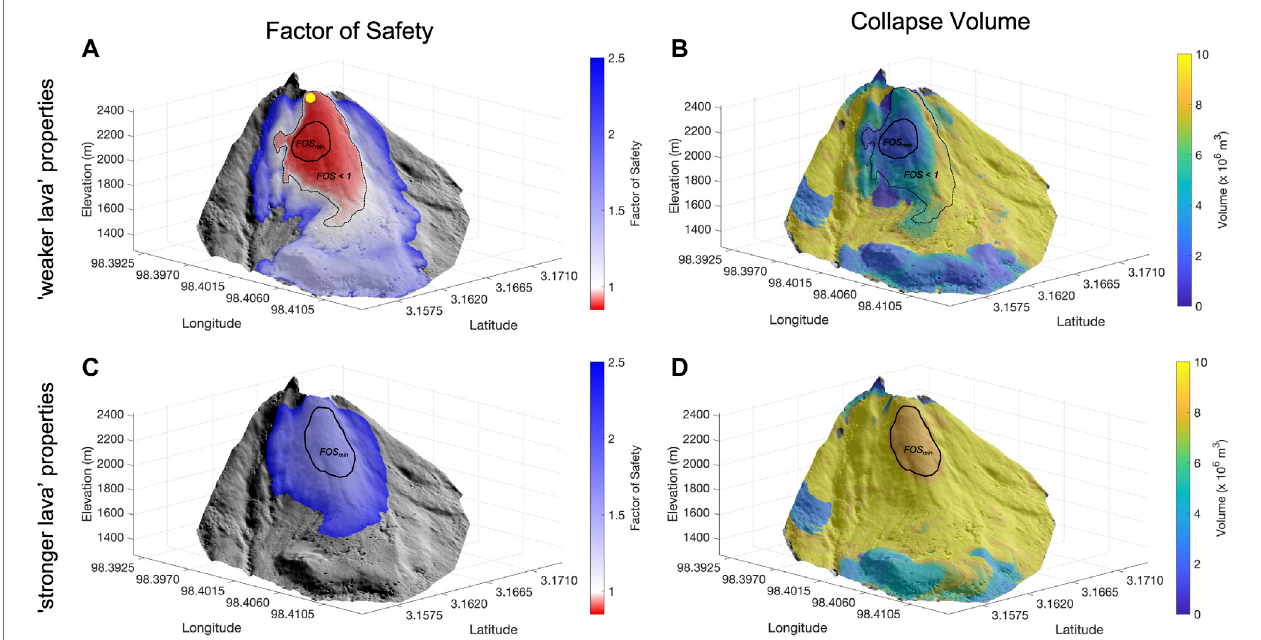
FIGURE 6 | Slope stability analysis results for the 2014 topography (uncapped collapse volume). Output from the Scoops3D model shows the FOS for the least stablefailureregion (A,C) andthevolumeofthatfailure (B,D) foreachDEMcell.Usingmaterialpropertiesrepresenting “ weakerlava ” (A,B) ,much oftheupper halfofthe lava fl owispotentiallyunstable,with FOS < 1(black dashed line).Theunstableareaincludes thelocationoftheinitialpassivecollapseinOctober2014(yellowdotin (A) ). The least stable potential collapse surface ( FOS min = 0.88) is located a few hundred meters downslope from the passive collapse location (black outline). For material properties representing “ stronger lava ” (C,D) , the entire edi fi ce is stable, with FOS min = 1.7. The least stable surface (black outline) is larger compared to the “ weaker lava ” material properties but includes much of the same area. Areas not colored in (A) and (C) have a FOS > 2.5. For both weaker and stronger lava properties, areas of lower FOS generally correspond with smaller predicted collapse